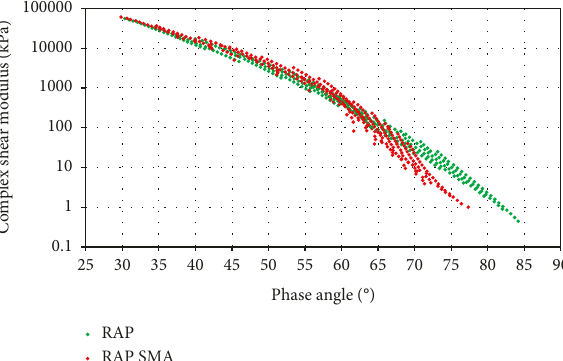
Figure 1: Black diagram—reclaimed binders from used RA.